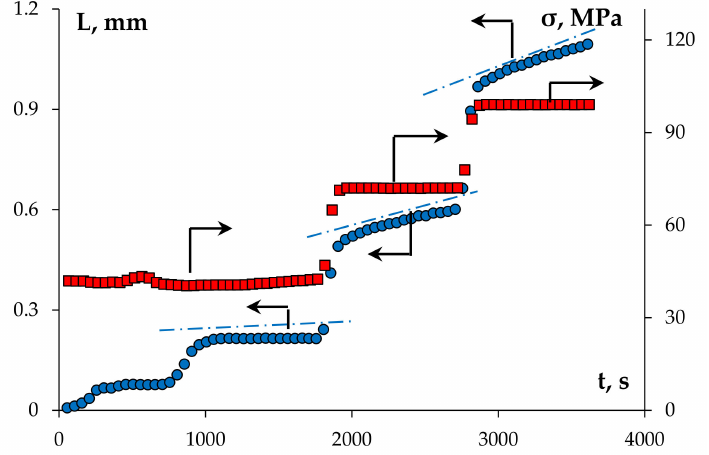
Figure 8. Dependence of shrinkage and pressure on time of stepped sintering with isothermal exposure of submicron α -WC + 10 wt.%Co powder at 800 ◦